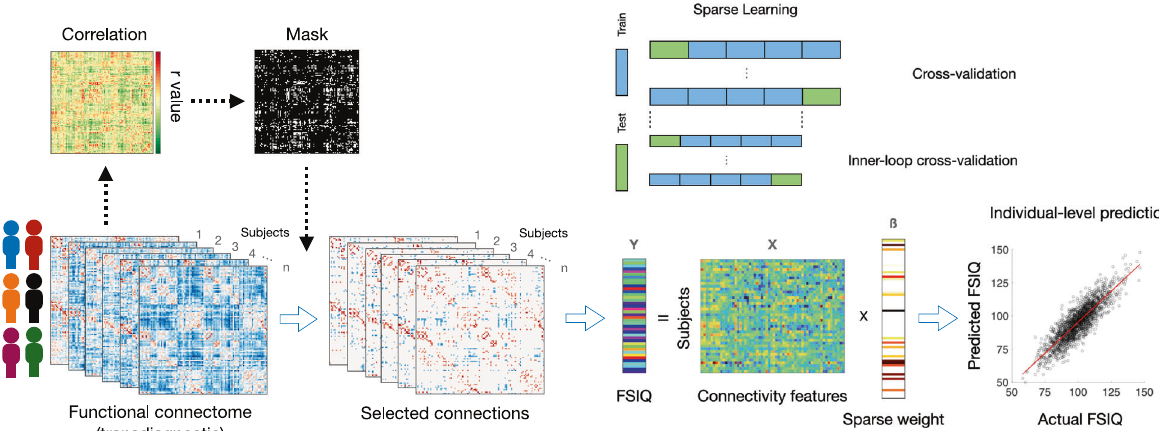
Fig. 1 A fl owchart of the transdiagnostic predictive modeling for intellectual capacity. First, the functional connectome is constructed using resting-state fMRI data of individuals from multiple diagnostic groups. Then, connectome-based predictive modeling (CPM) applies a mask on the functional connectome based on its correlation with intellectual capacity, quanti fi ed by Full-Scale Intelligence Quotient (FSIQ), to reduce feature dimensionality. A sparse learning algorithm (LASSO) with cross-validation further selects predictive connections and derives feature weights to generate individual-level prediction of